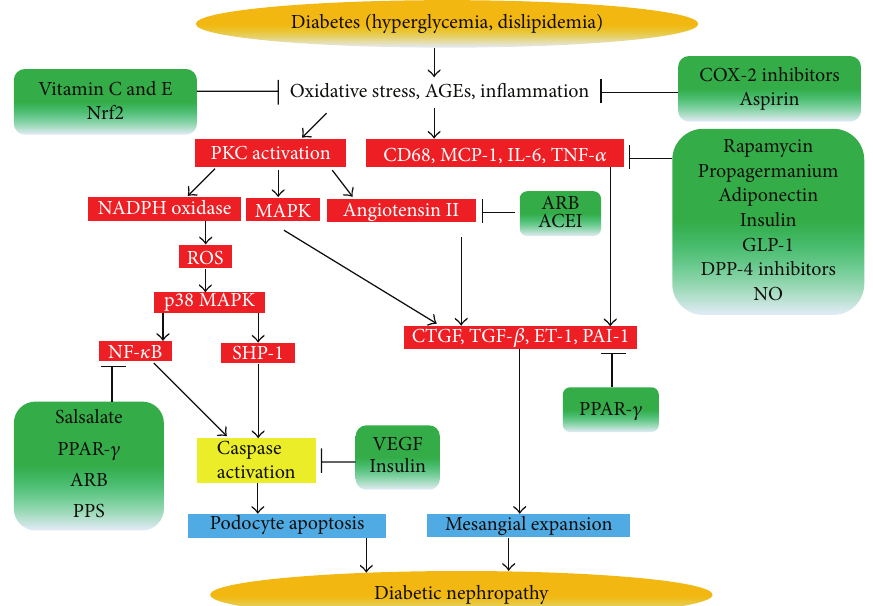
Figure 1: Schematic diagram on the progression of diabetic nephropathy and its inhibition. AGEs: advanced glycation end products; PKC: protein kinase C; COX-2: cyclooxygense-2; Nrf2: NFE2-related factor 2; NADPH: nicotinamide adenine dinucleotide phosphate; MAPK: mitogen-activated protein kinase; MCP-1: monocyte-chemoattractant protein-1; IL-6: interleukin-6; TNF- 𝛼 : tumor necrosis factor- 𝛼 ; GLP- 1: glucagon like peptide-1; DPP-4: dipeptidyl peptidase-4; NO: nitric oxide; ARB: AT1 receptor blockers; ACEI: angiotensin-converting enzyme inhibitors; NF- 𝜅 B: nuclear factor- 𝜅 B; CTGF: connective tissue growth factor; TGF- 𝛽 : transforming growth factor- 𝛽 ; VEGF: vascular endothelial growth factor; SHP-1: Src homology-2 domain-containing phosphatase-1; PPAR- 𝛾 : peroxisome proliferator-activated receptor- 𝛾 ; PPS: pentosan